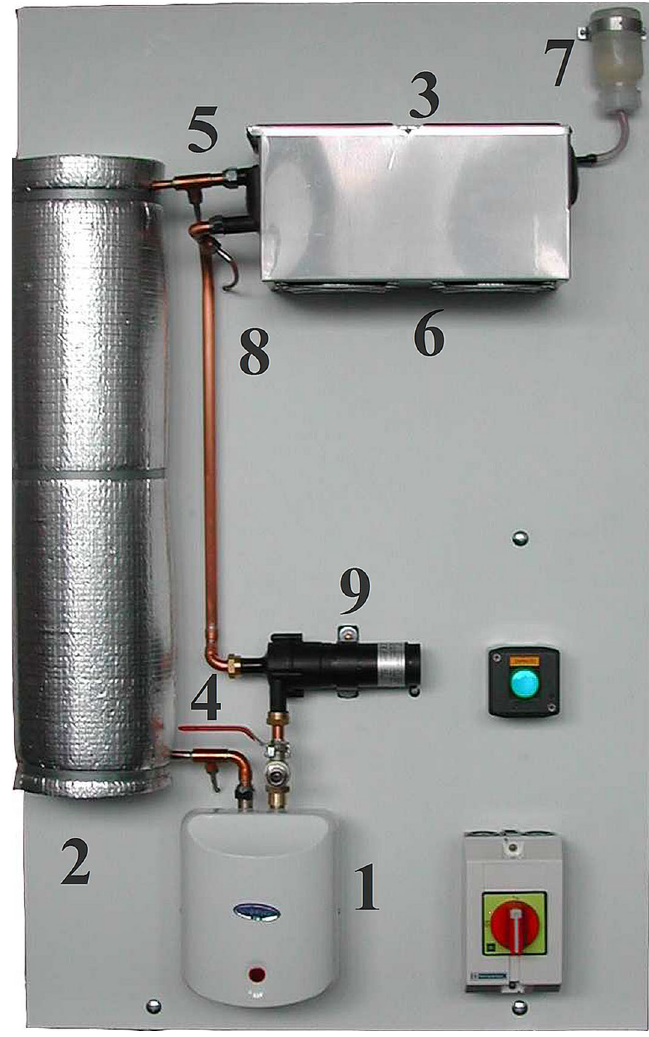
Figure 8. The HETDM